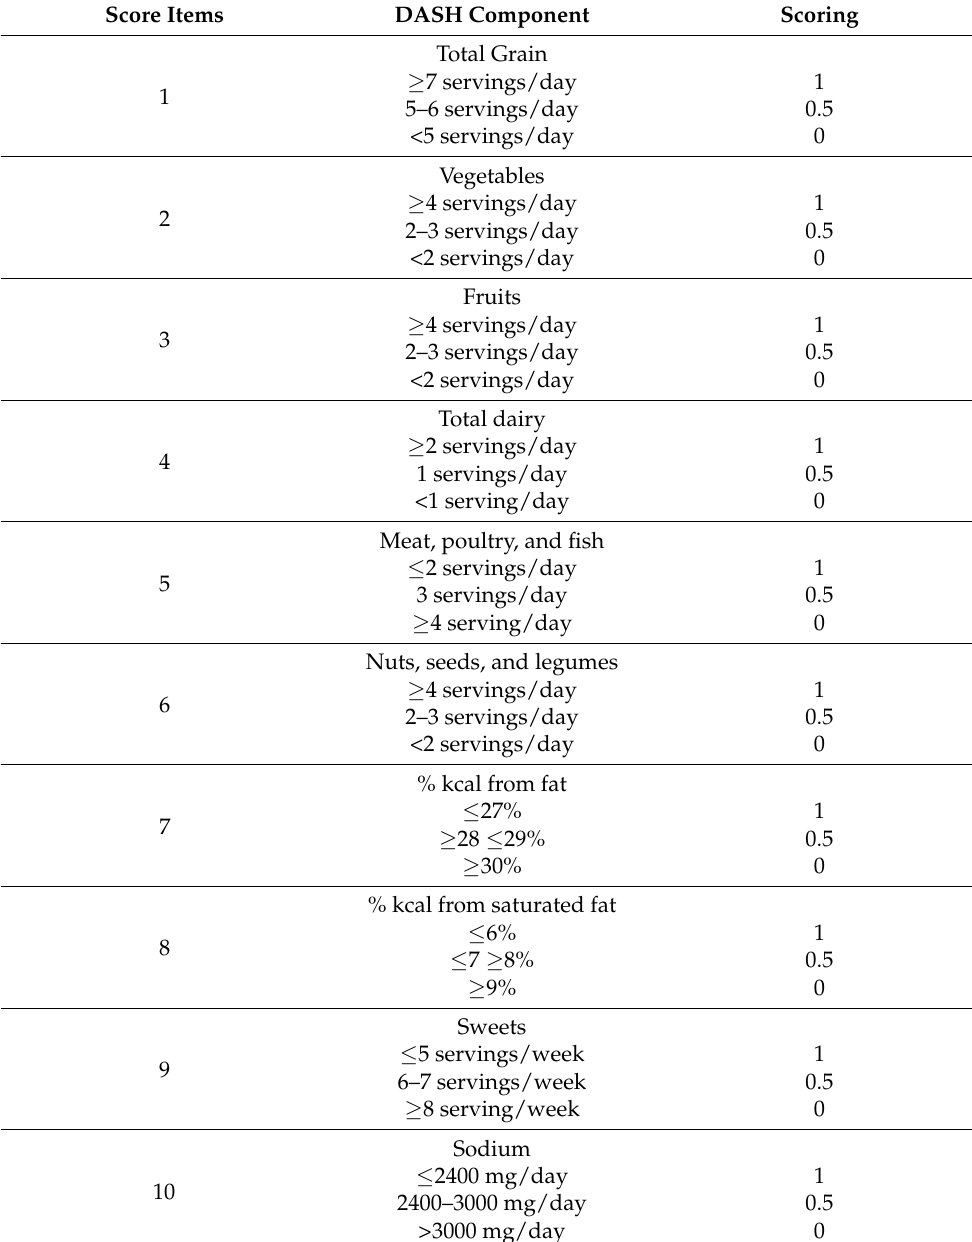
Table 1. Scoring criteria for DASH Dietary